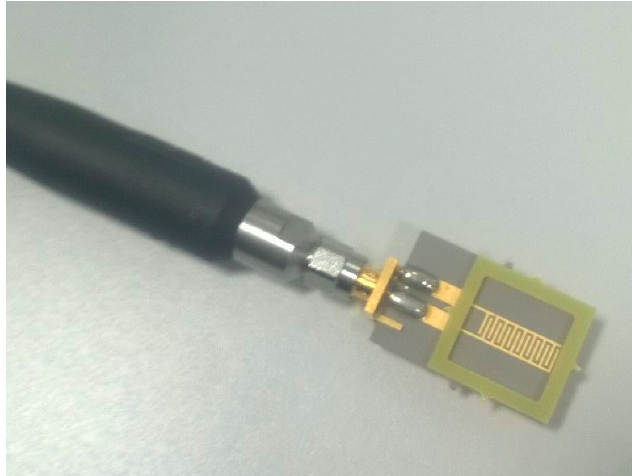
Figure 2. PTFE 8pr Au sensor with FR4 reservoir and SMA connector.